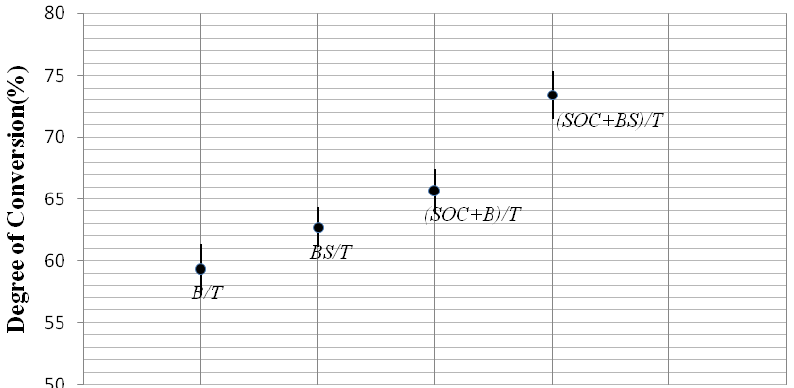
Figure 2. The degree of conversion of the four groups of resin